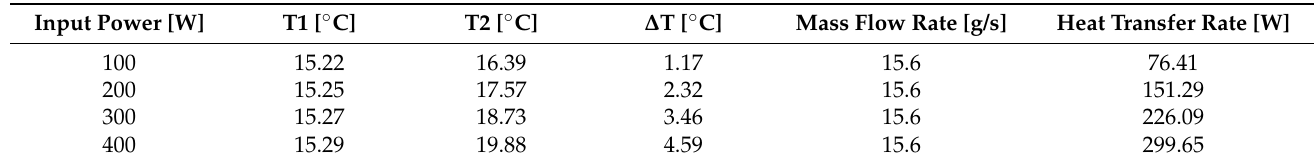
Table 2. Numerical thermal results for different input power